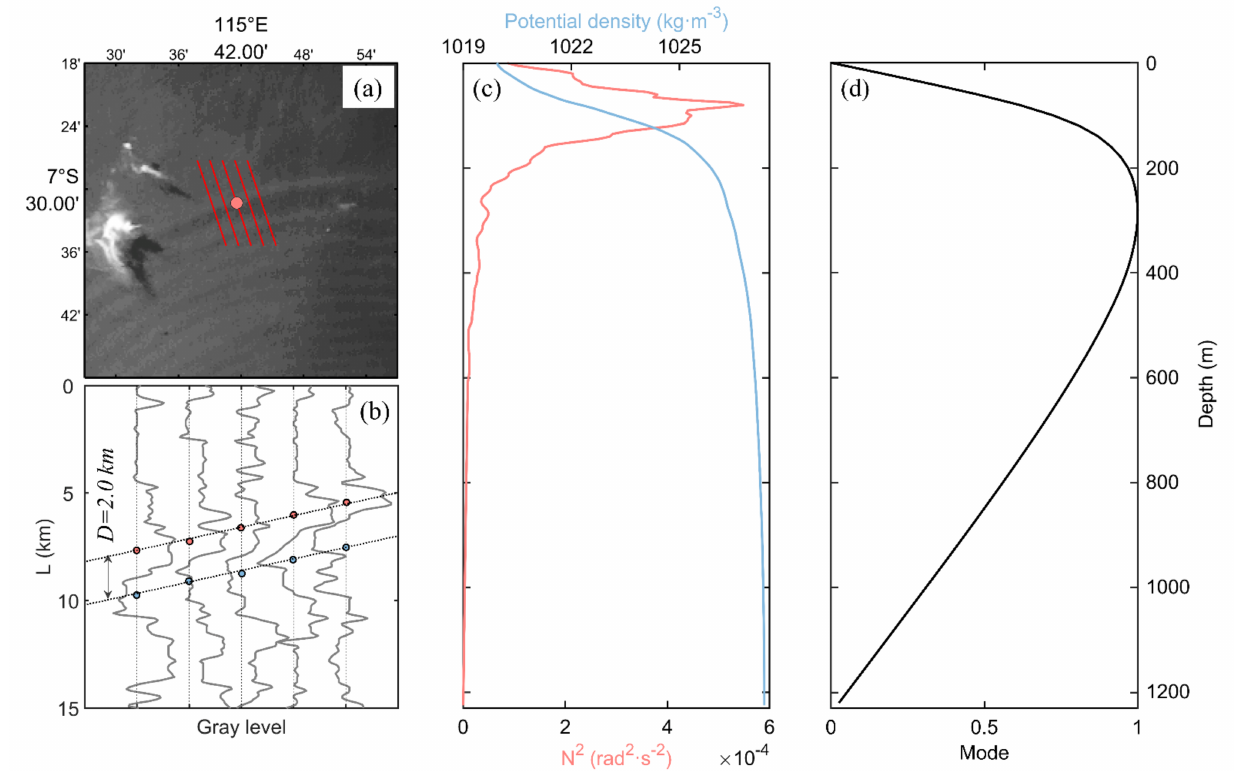
Figure 4. ( a ) Local amplification of the ISW occurring in the BS basin within the remote sensing image from 12:55 19 April local time. ( b ) Gray level changes along the red line in ( a ). ( c ) Climatological potential density and Brunt-Väisälä frequency profiles calculated from WOA18 data at the pink dot site in ( a ). ( d ) First-mode of the